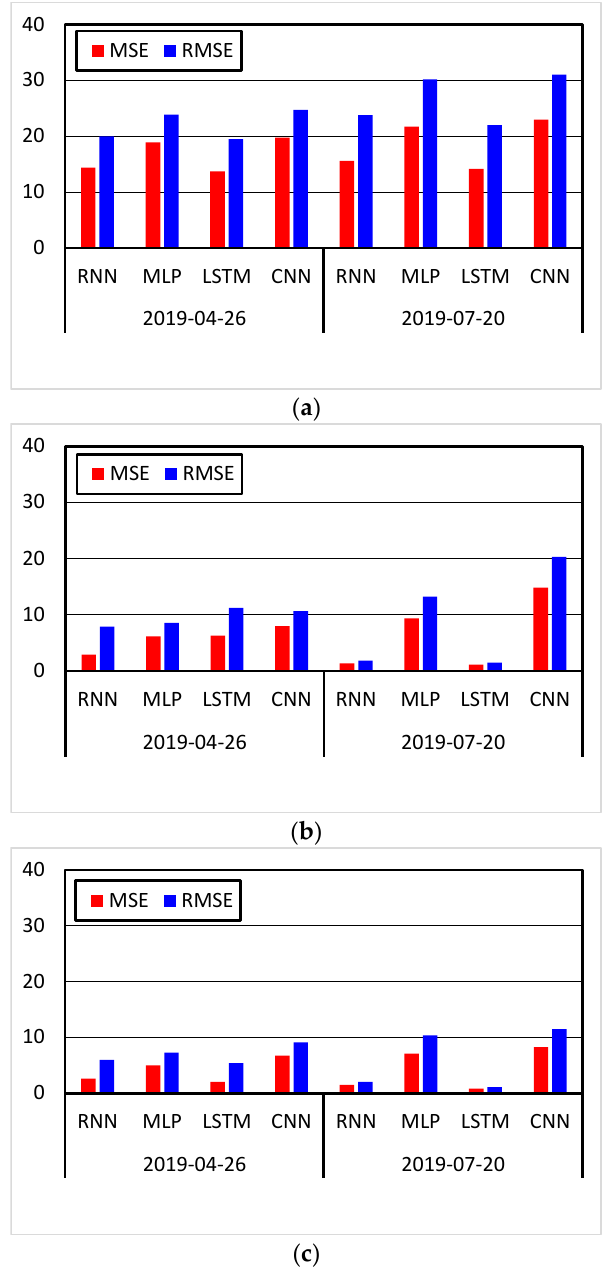
Figure 22. Training result error for each algorithm as a function of the number of input datasets for the conditions of Cases 1 and 2: ( a ) the two datasets with the highest correlation; ( b ) six datasets with high correlation; and ( c ) all training data .